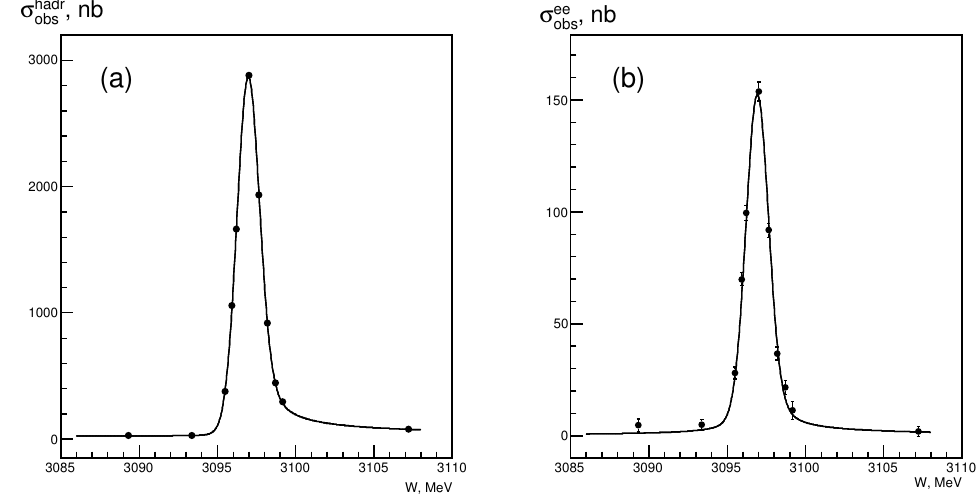
Figure 2 . Observed cross section as a function of the c.m. energy (a) for e + e (cid:0) ! J= ! hadrons and (b) for e + e (cid:0) ! J= ! e + e (cid:0) processes. The curves are the result of the combined (cid:12)t, (cid:31) 2 of the (cid:12)t equals 6.6 and 9.0 for the hadronic and leptonic channels, respectively, with the total number of degrees of freedom